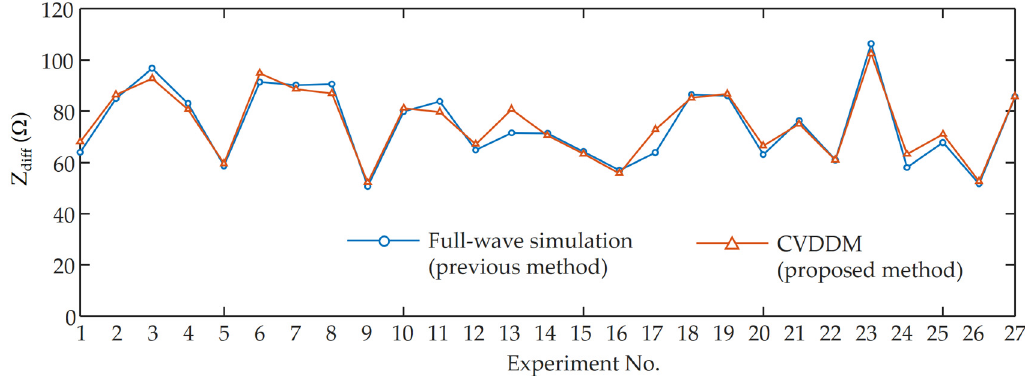
Figure 8. Comparison of differential impedances between the proposed CVDDM and the full-wave simulation for the cases of the Taguchi analysis.